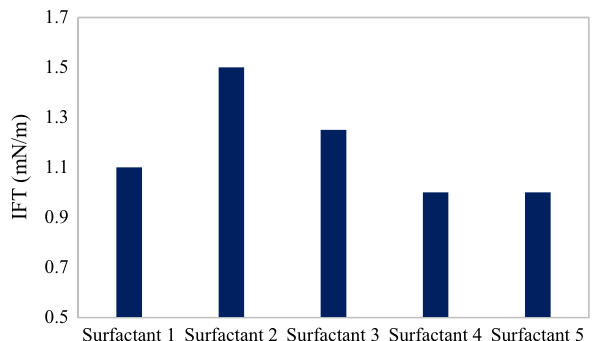
Fig. 5 Emulsification Viscosity measured at 100 °C and at two differ- ent volumetric fractions of the crude oil